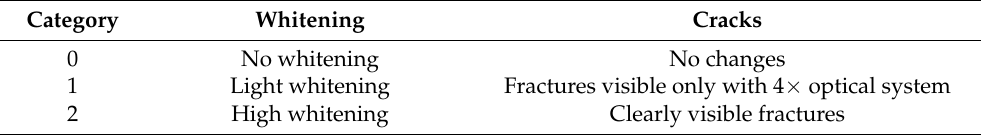
Table 2. Categories for whitening and cracks development following the climatic chamber exposure. Category